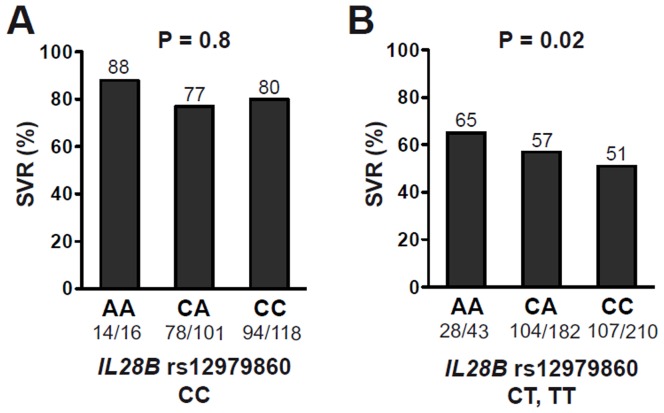
Treatment response according to CYP27B1-1260 rs10877012 genotype.Overall sustained virologic response (SVR) rates across all HCV genotypes are shown for patients (A) with IL28B rs12979860 genotype CC and for (B) patients with IL28B rs12979860 genotype CT or TT. Numbers above bars indicate SVR rates in percent. Numbers below bars indicate absolute numbers of patients with SVR/all patients.